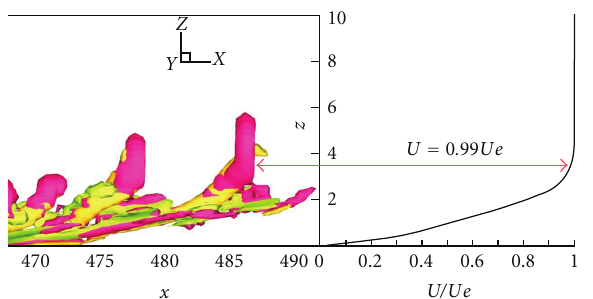
Figure 15: The shape and position of ring-like vortices in boundary layer ( z = 3 . 56, U = 0 . 99 Ue ).